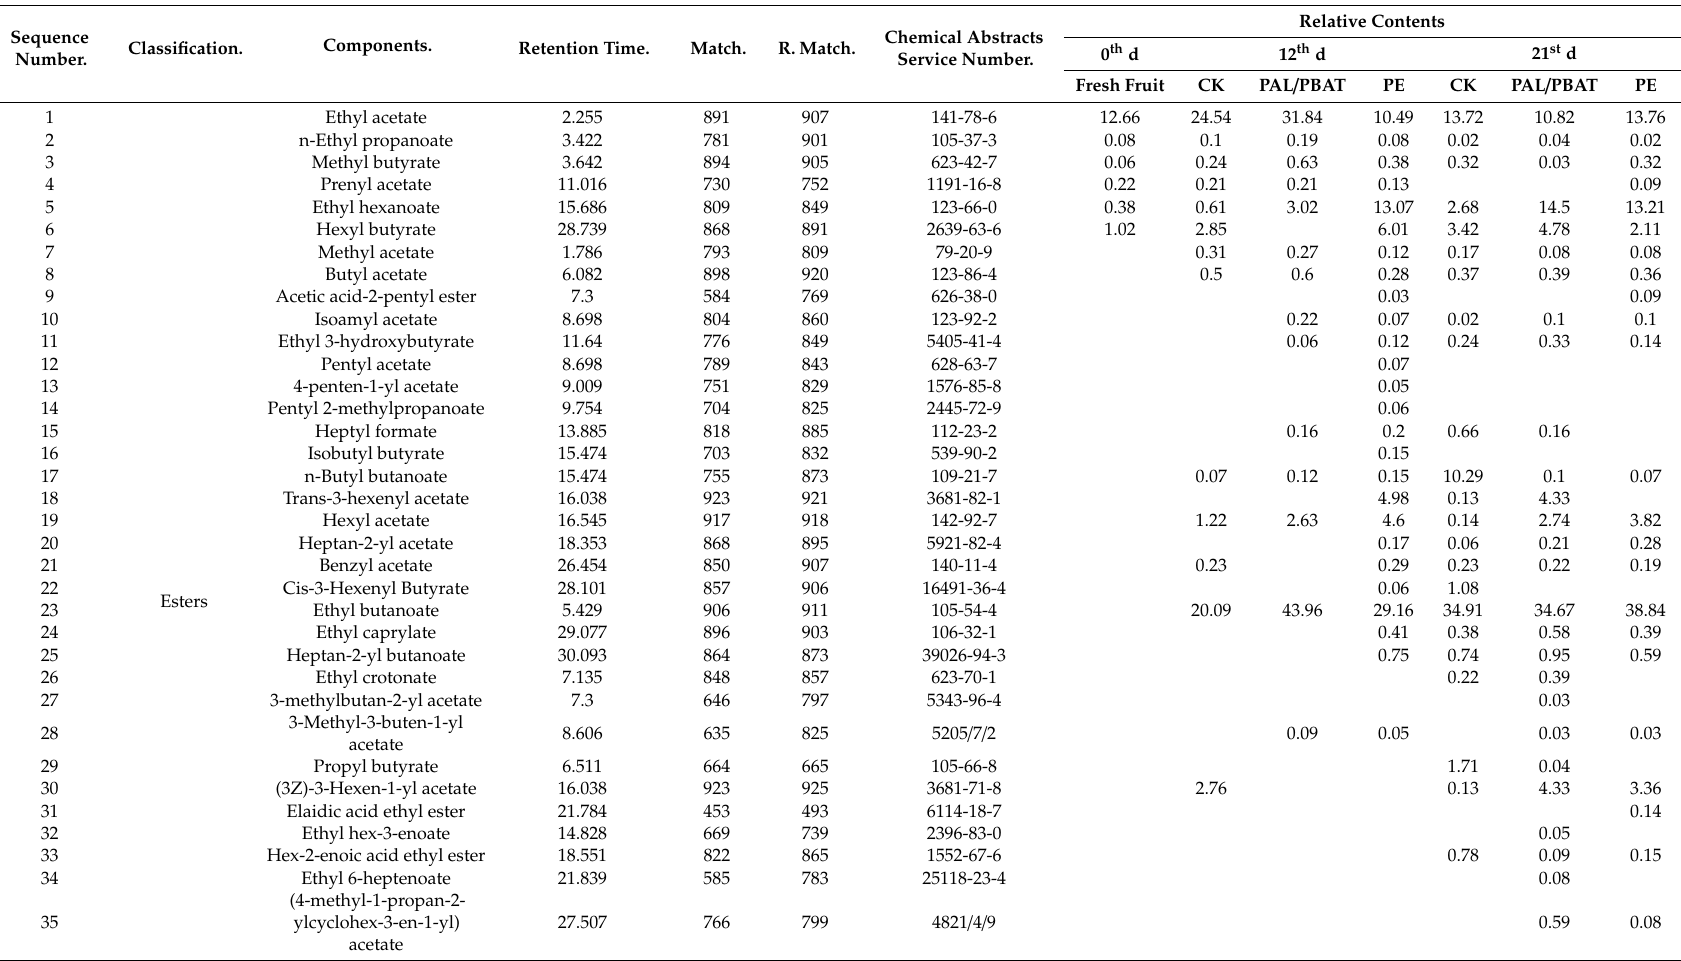
Table A1. Volatile and odoriferous compounds of the passion fruit in di ff erent packaged, corresponding to the 0 th day, 12 th day and 21 st day by GC-MS. Sequence